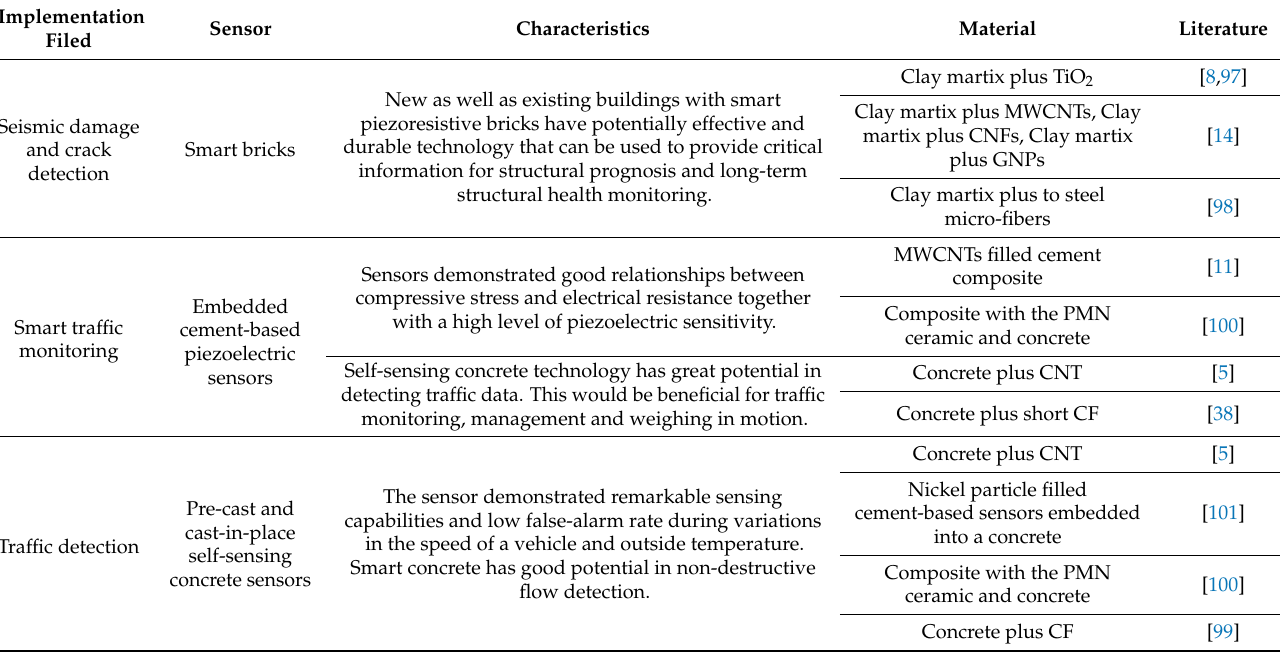
Table 6. Potential applications of self-sensing